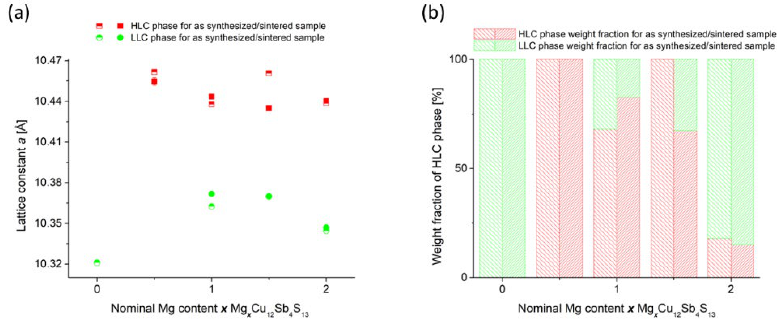
Figure 8. Lattice constants measured for tetrahedrite phases present in Mg x Cu 12 Sb 4 S 13 samples after sintering ( a ) and weight fraction of the high lattice constant phase in these samples ( b ) .